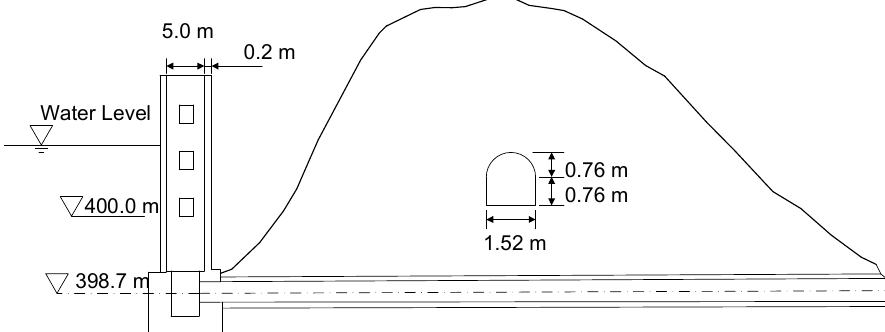
Figure 1. A window ‐ type draining system in a tailing pond. Figure 1. A window-type draining system in a tailing